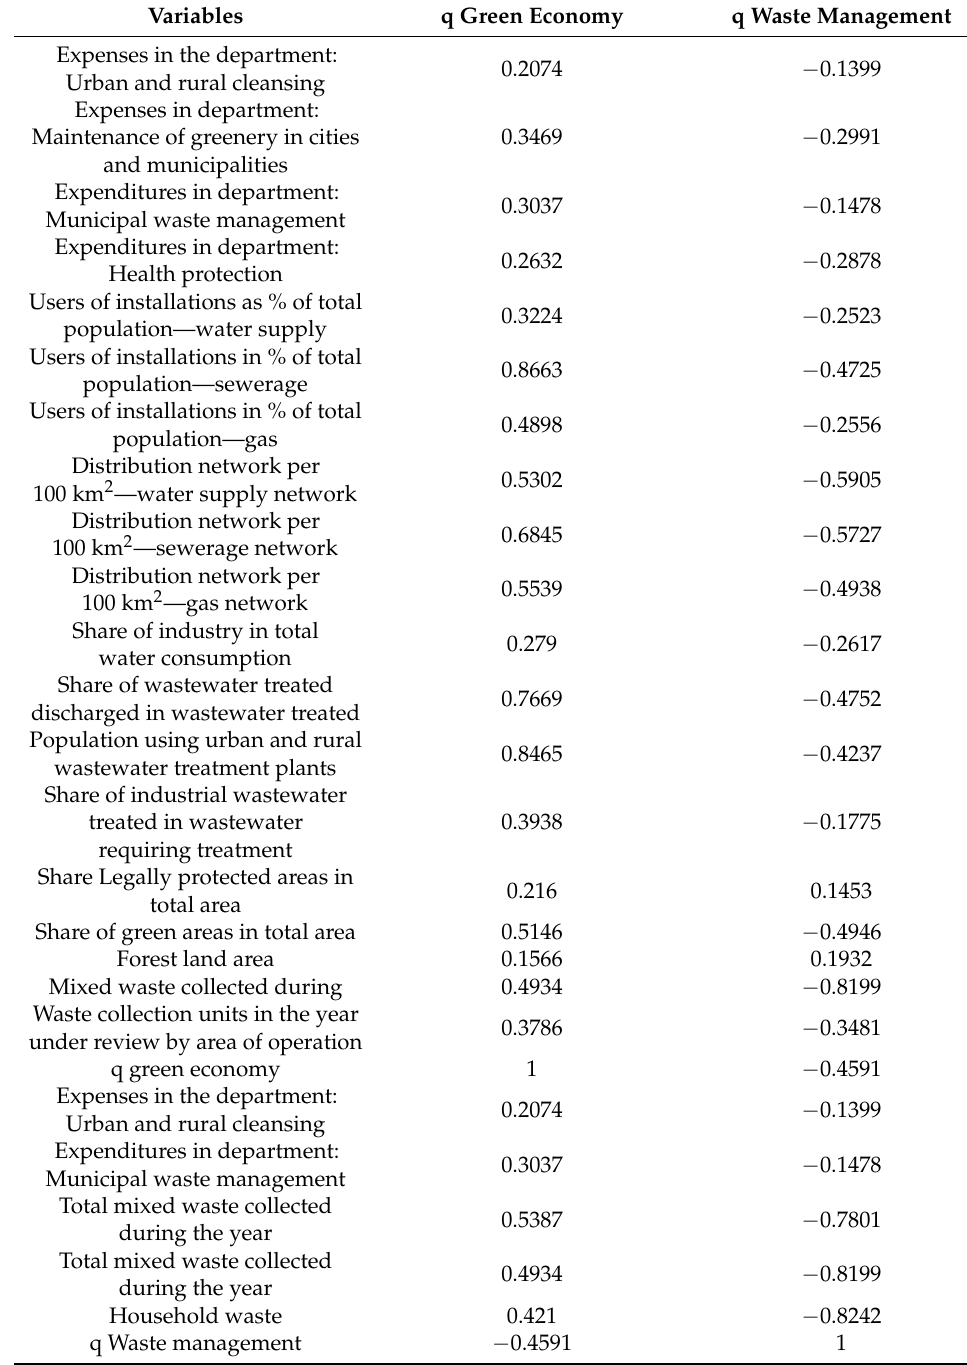
Table 3. Coefficients of correlation between the value of waste management (zero west) and ecology and natural environment of poviats and their values in